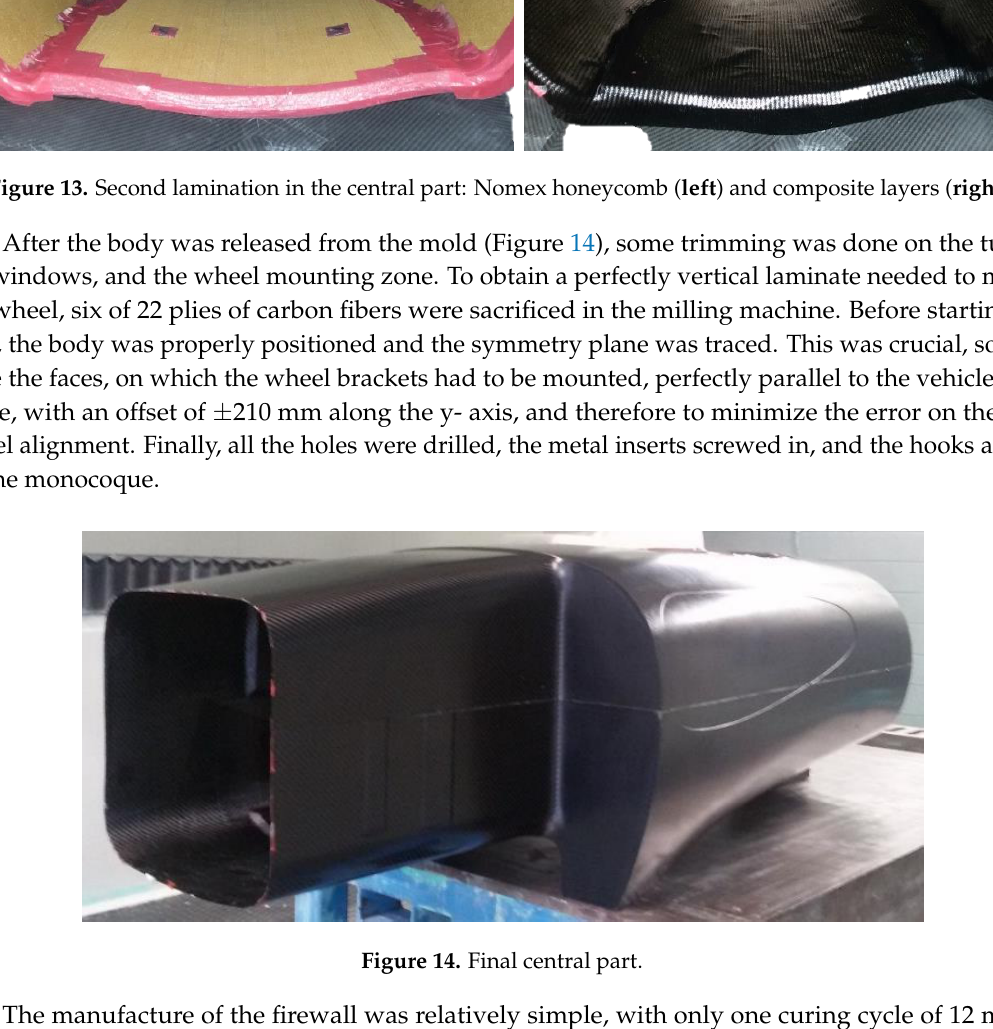
Figure 12. First lamination: Release film ( left ) and vacuum bag ( right ) on the female central mold .